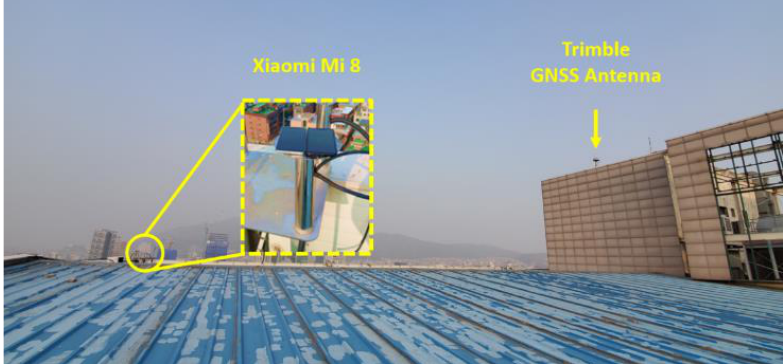
Figure 10. Test Environment at the Roof of the Chung-moo building in Sejong University.